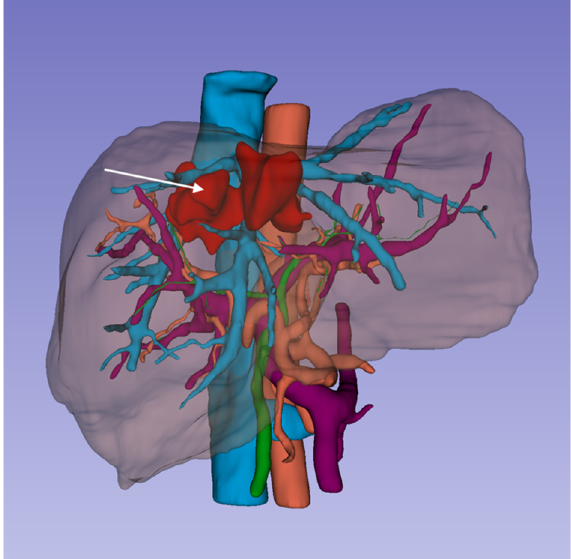
Figure 1. 3D surface models of liver parenchyma and its bilio-vascular structures with the intrahepatic lesion (right lobe hematoma, white arrow) obtained from segmentation of medical imaging. The virtual models were exported in STL files for 3D printing.